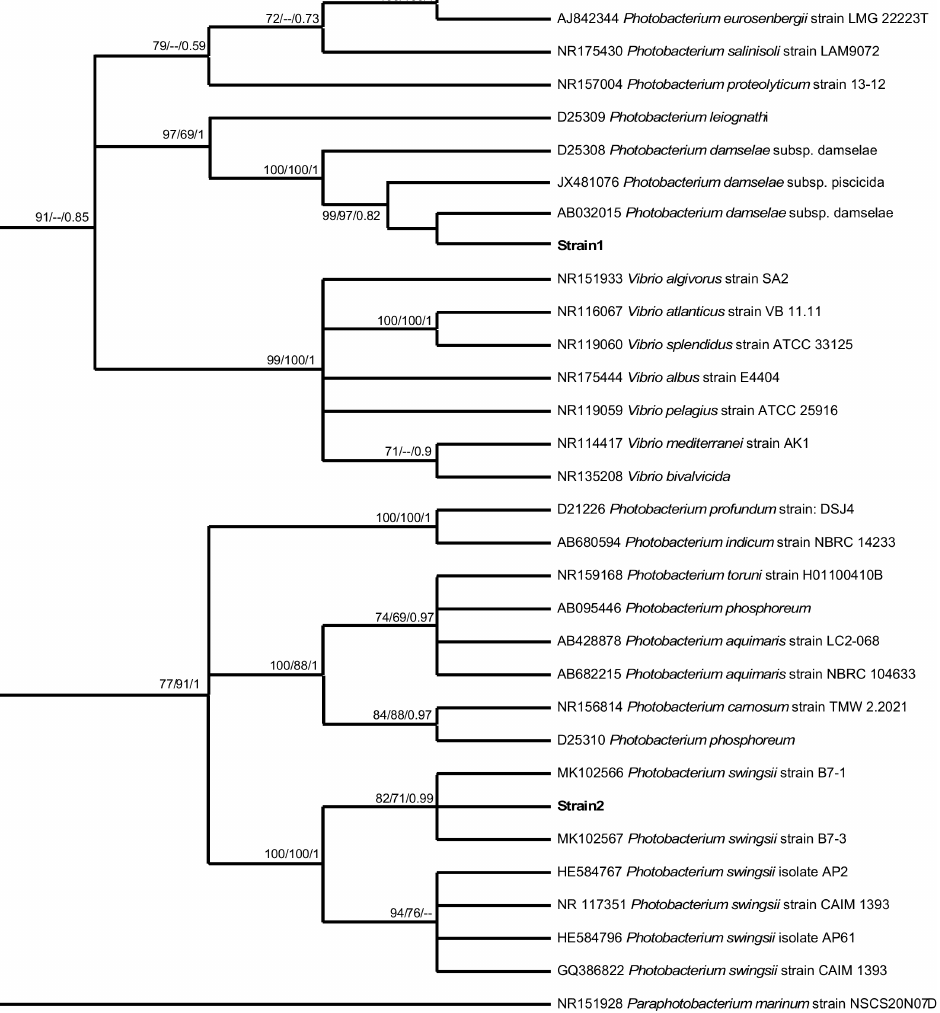
Figure 3. Phylogenetic relationships based on the sequence of the partial 16SrDNA gene. Neighbor- joining, maximum likelihood, and Bayesian Inference bootstrap values higher than 50% are indicated below nodes, respectively.